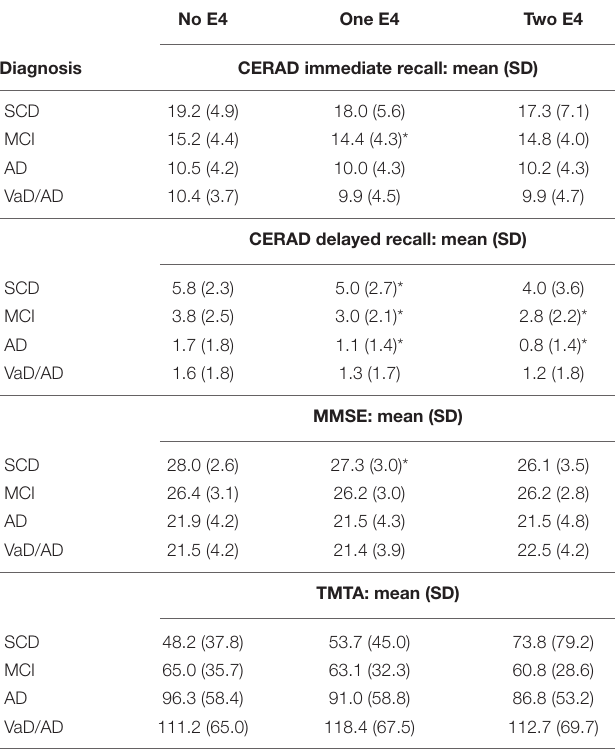
TABLE 2 | Cognitive scores by diagnosis and E4